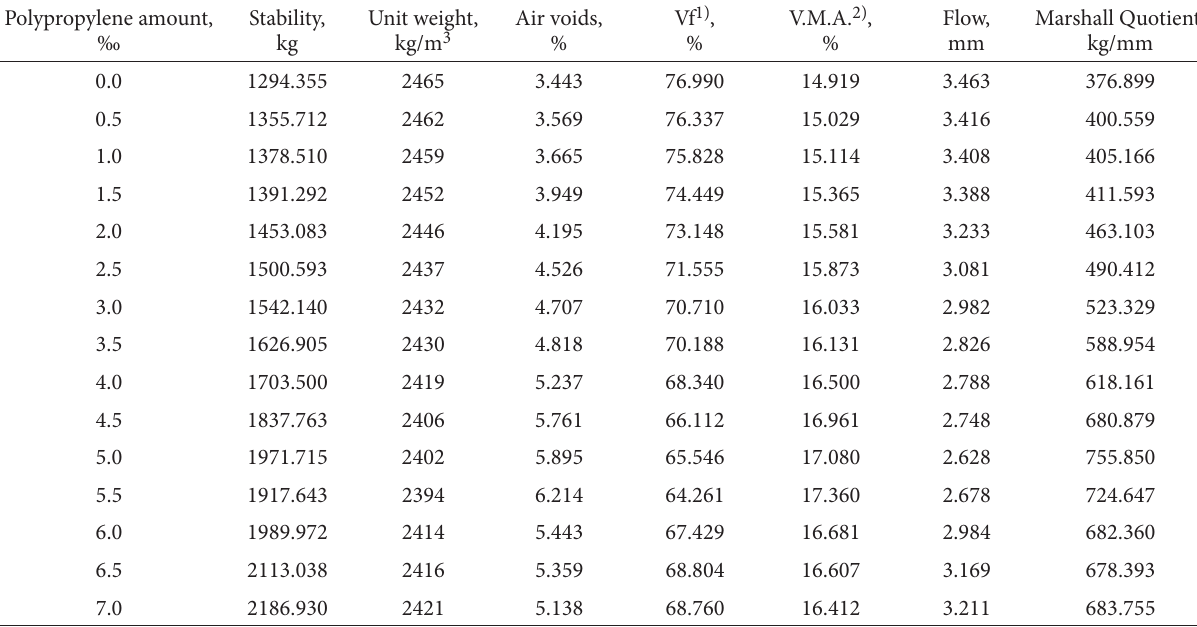
Table 6. The average physical and mechanical values obtained for 15 sets of